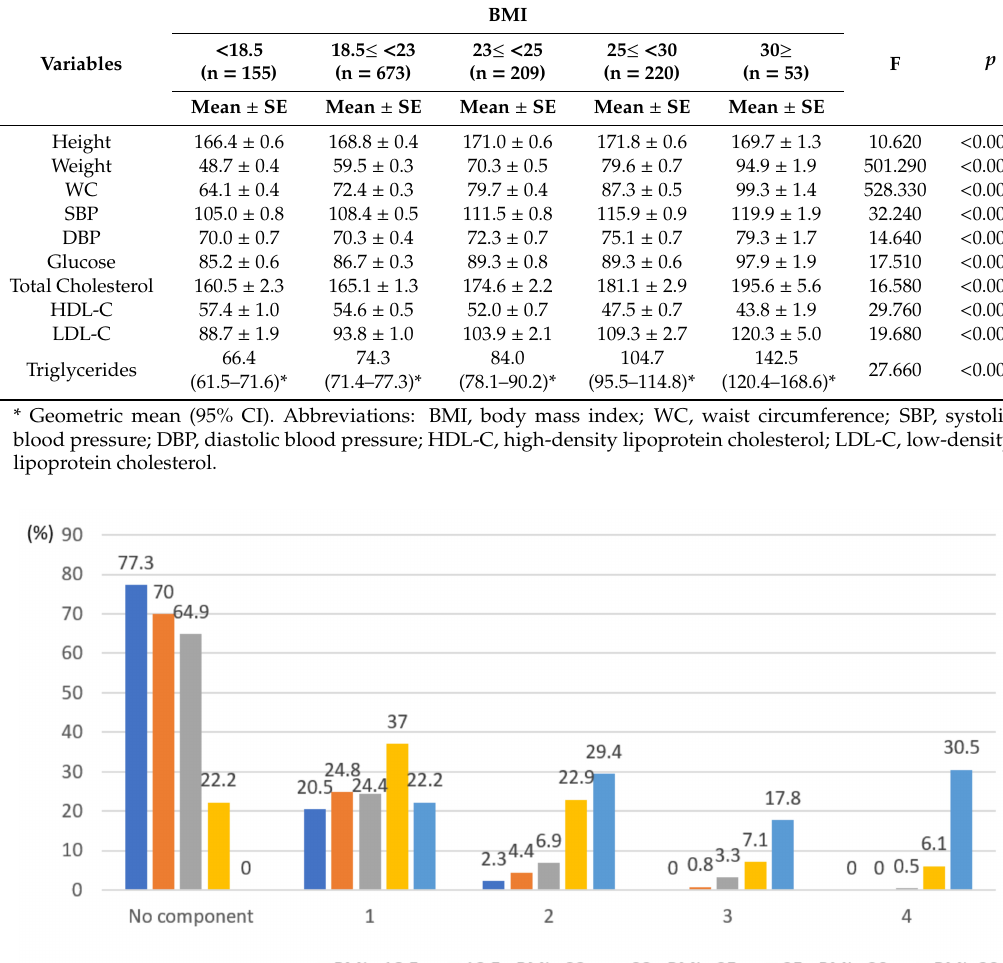
Table 3 indicates BMI classifications in relation to anthropometric measures, biochemical, and clinical variables. All variables, namely, height ( p < 0.0001), weight ( p < 0.0001), waist circumferences ( p < 0.0001), systolic blood pressure ( p < 0.0001), diastolic blood pressure ( p < 0.0001), fasting blood sugar